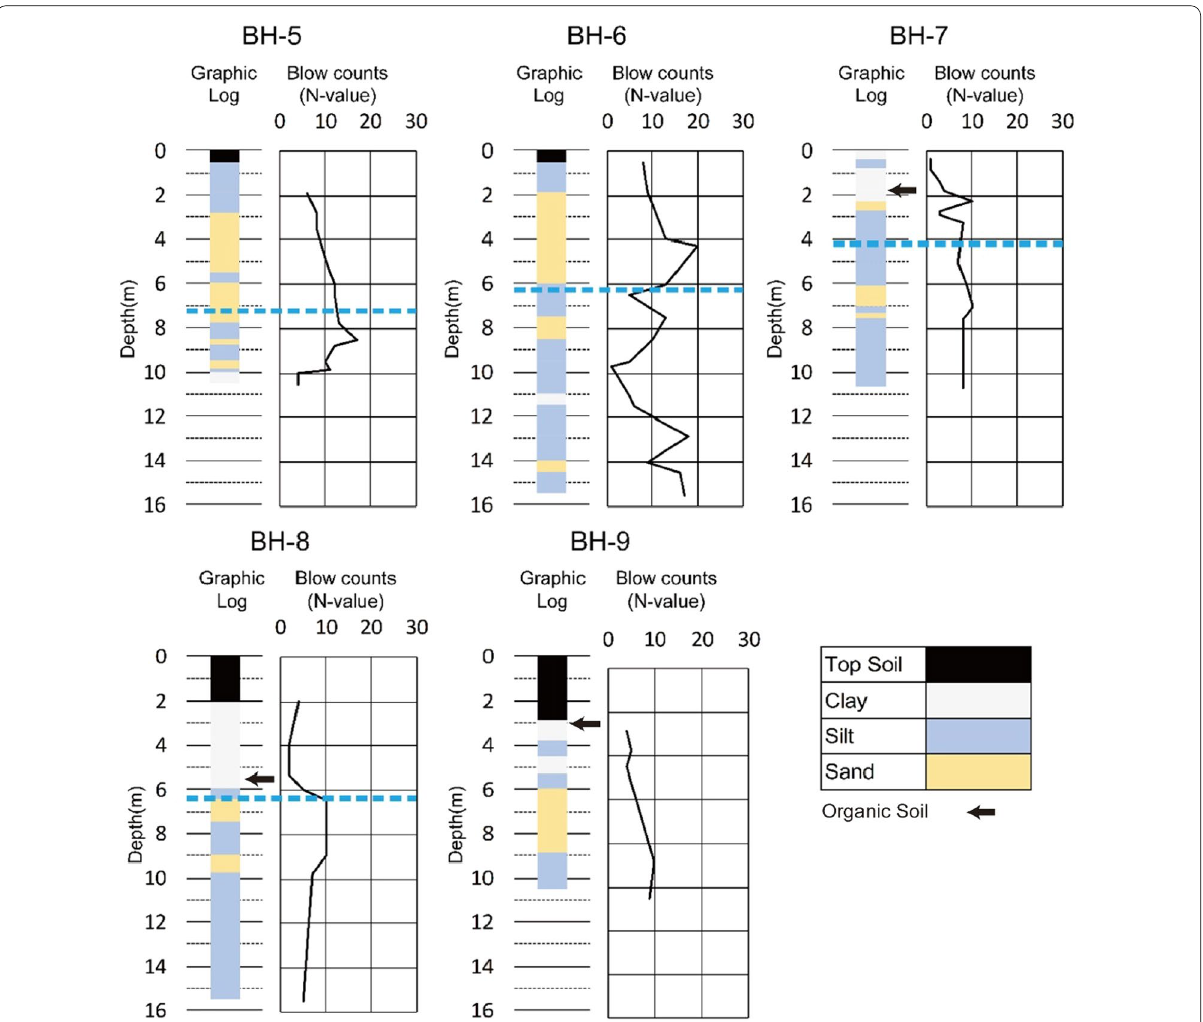
Fig. 7 Soil classifications and SPT N-value distributions at 5 boreholes. Blue dotted lines show the initial water level of each borehole after reaching that